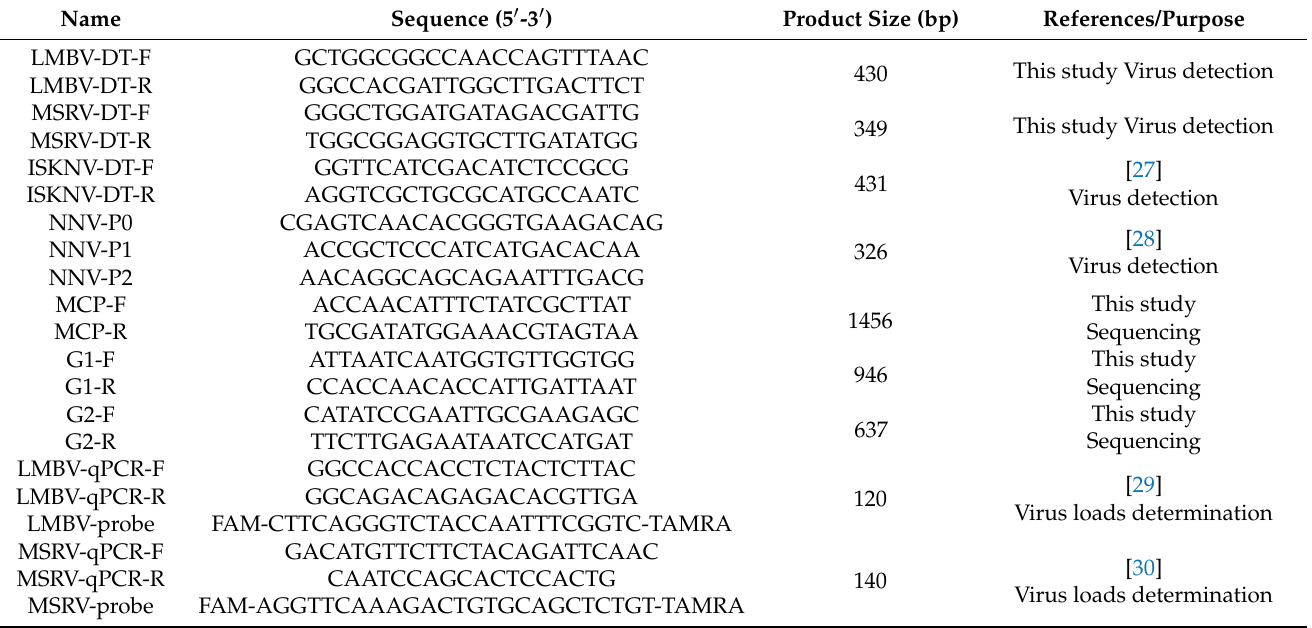
Table 1. Primers and probes used in this